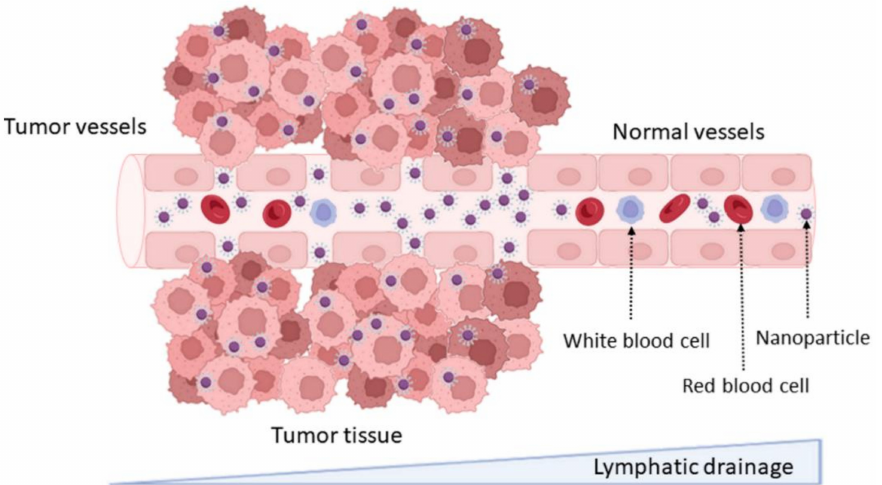
Figure 2. Schematic representation of the enhanced permeability and retention effect and passive targeting mechanisms.